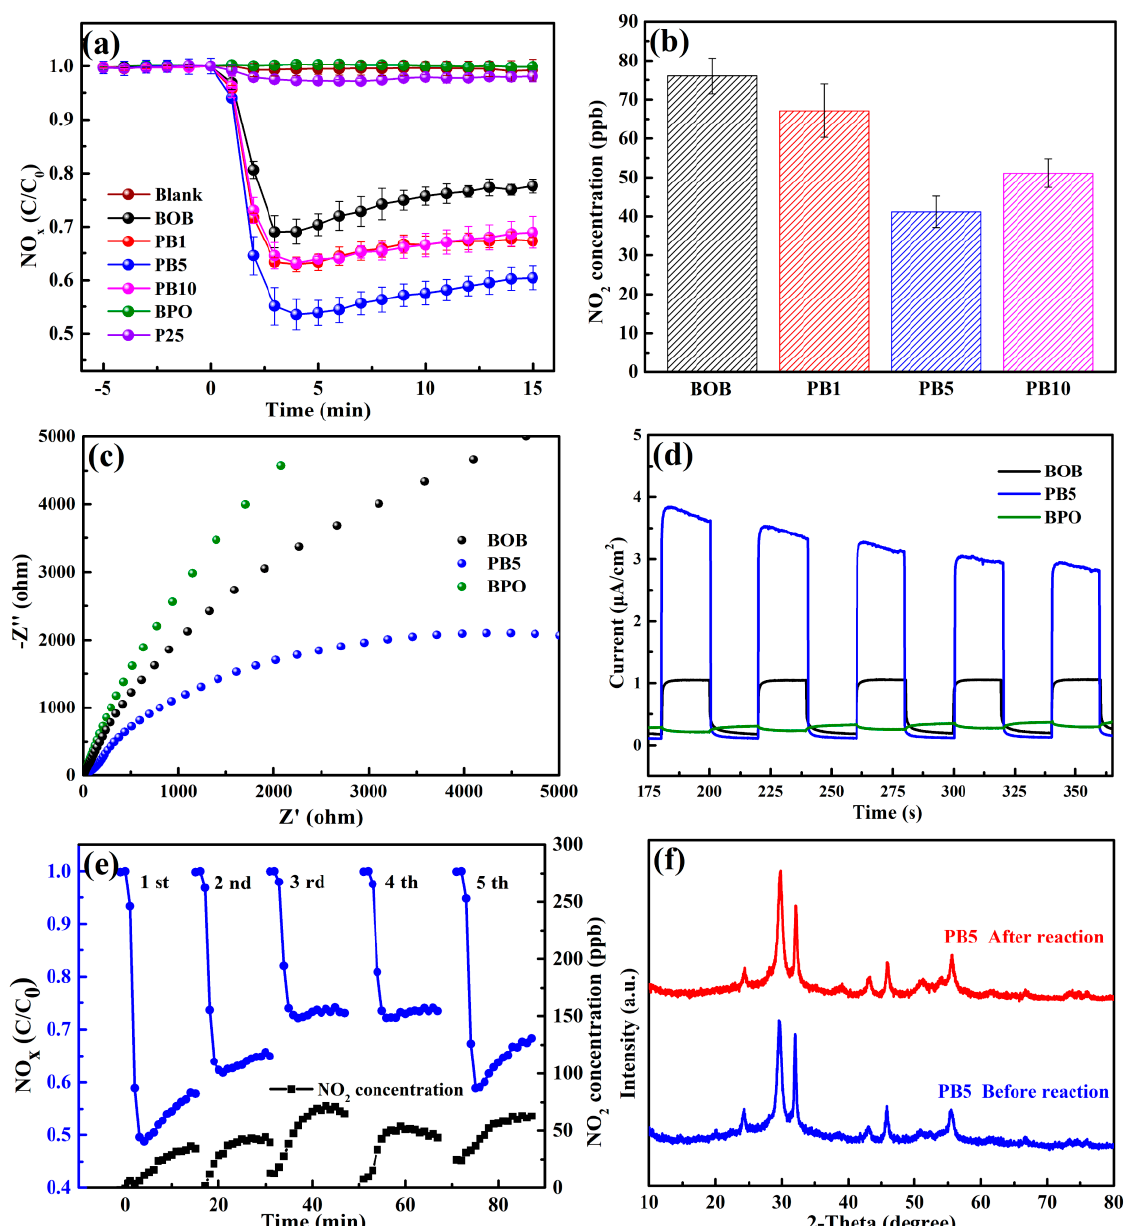
Figure 4. Photocatalytic NO x removal over different catalysts in visible light ( a ); NO 2 generation after 15 min caused by BOB and the PBX series ( b ); EIS spectra ( c ) and transient photocurrent response ( d ) of BOB, BPO, and PB5; photocatalytic NO x removal and NO 2 generation by PB5 for four successive cycles and a fifth by washing ( e ); XRD patterns of PB5 before and after five cycles ( f ).